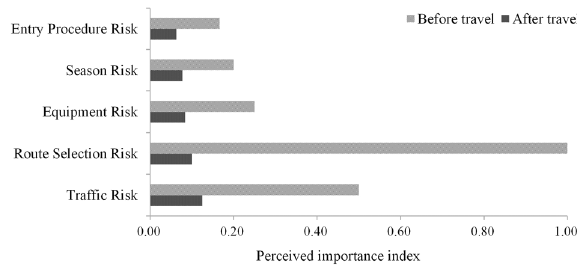
Fig. 9 Risks with perceived importance signi fi cantly decreased after travel. The experiment results indicate that tourists are overly concerned about these risks before